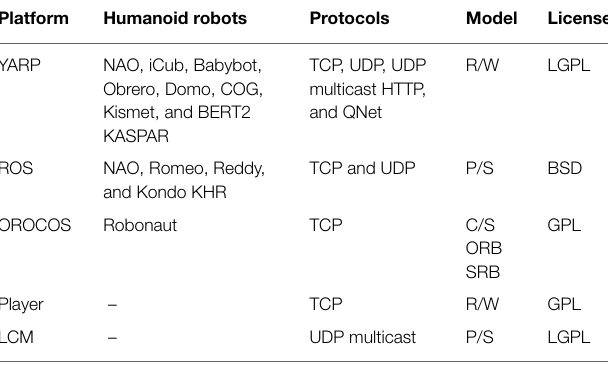
TABLE 1 | A comparison of popular robot middleware platforms, including the supported humanoid robot platforms, communication protocols, and interaction models